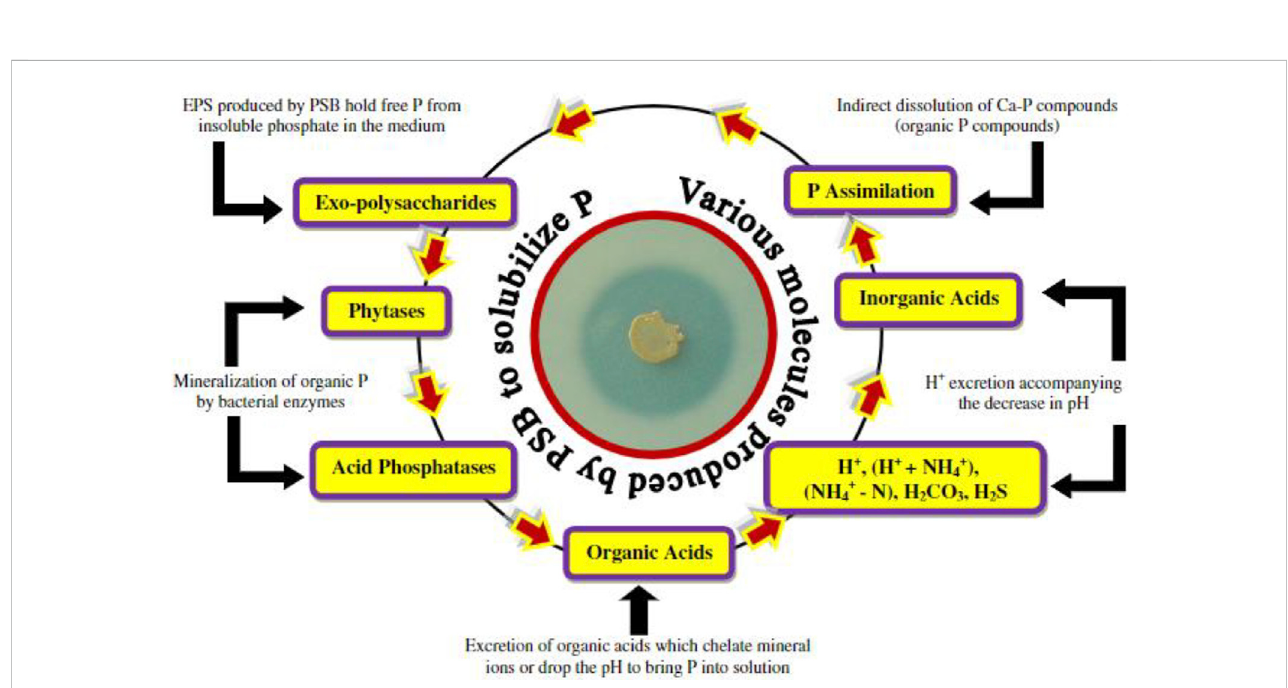
FIGURE 4 Different organic and inorganic substances produced byphosphate solubilizing bacteria for P, solubilization from soil adoptedfrom (Ahemad and Kibret 2014).